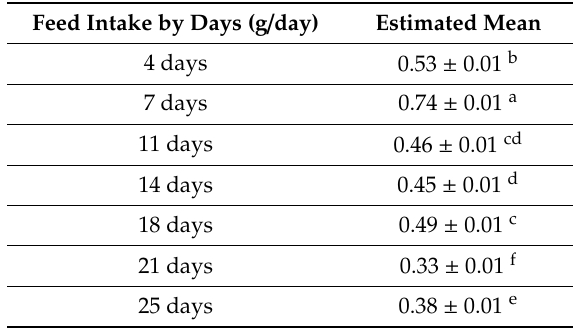
Table 1. Temporal variation of feed intake for all mice considered as one group ( n = 75). Data are expressed as mean ±